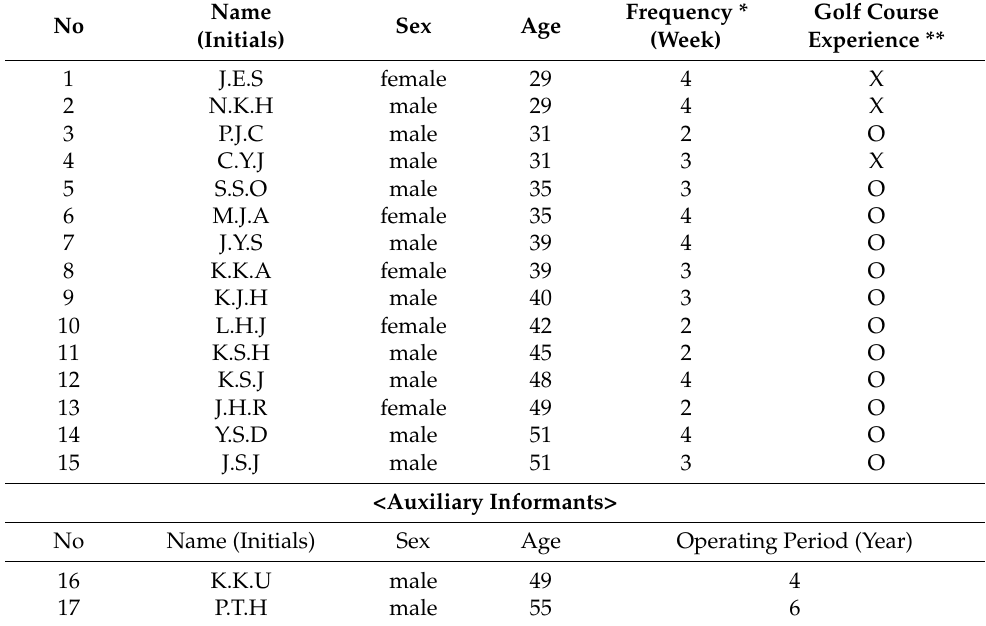
Table 1. Characteristics of the